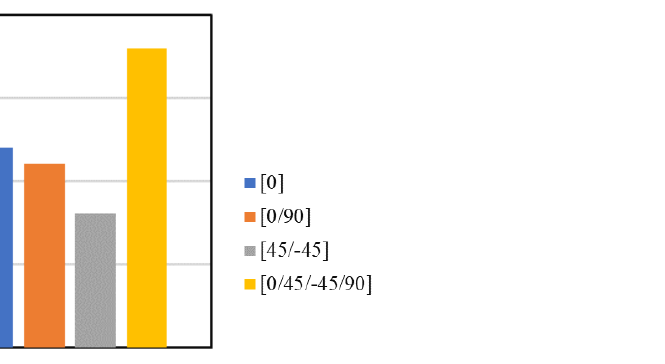
Figure 18. Effect of stacking sequence on failure load composite single lap joint. Adapted from [43].